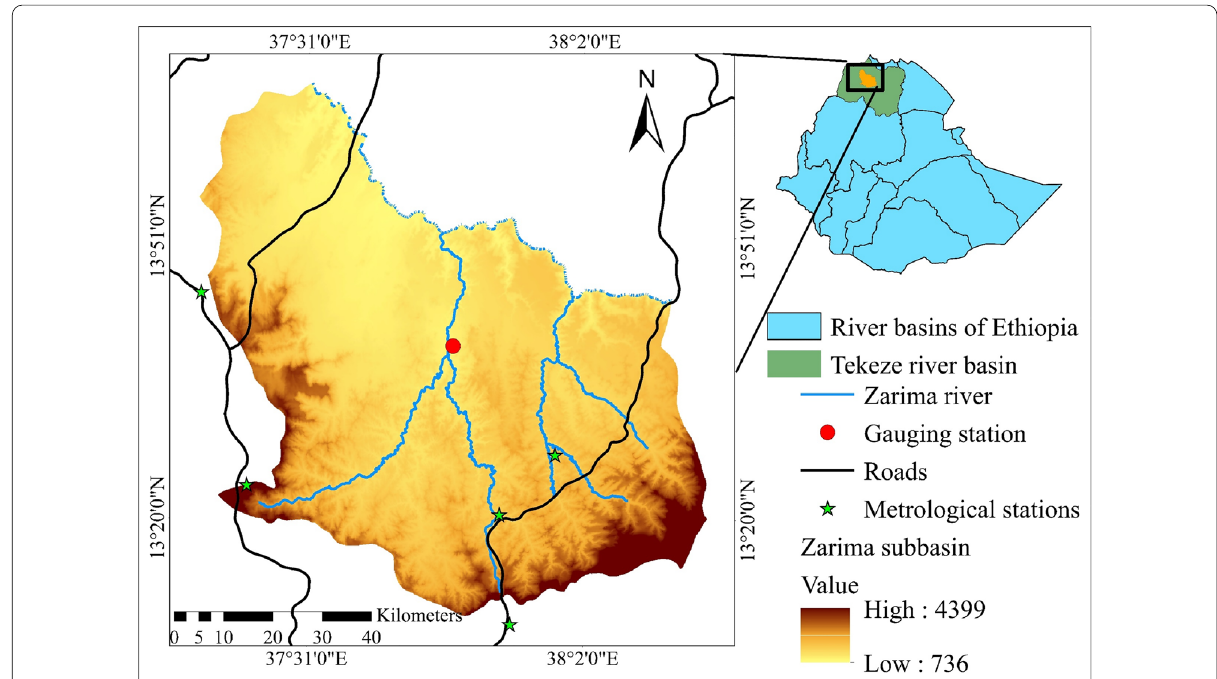
Fig. 1 Topographic map of Zarima